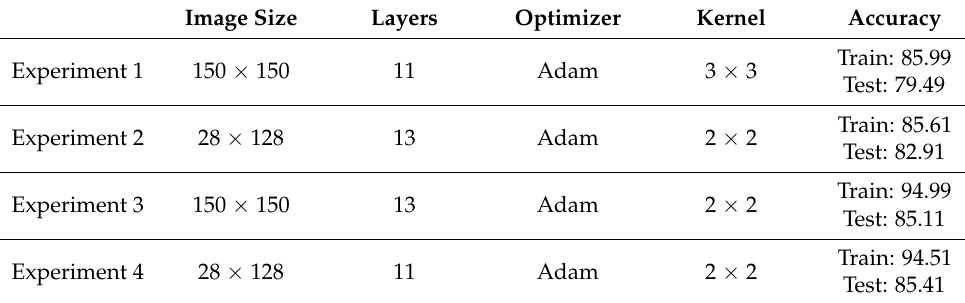
Table 1. Effect of various parameters of CNN without